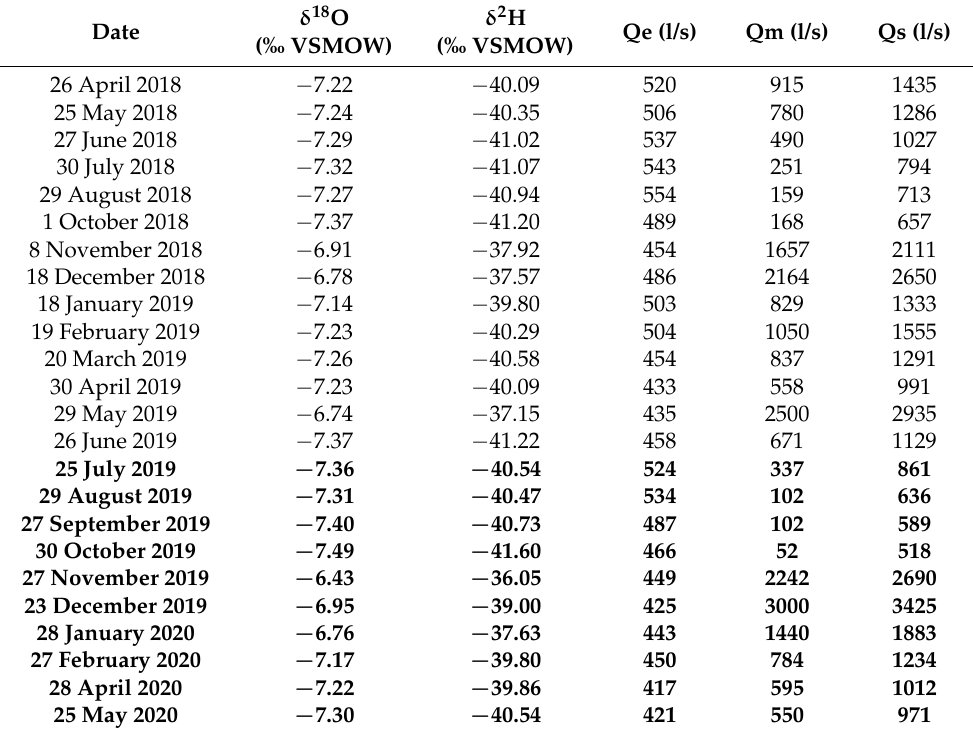
Table 1. Isotope composition of spring water ( δ 18 O, δ 2 H), flow rates exploited by the local water supply (Qe), excess flow rates measured in the river (Qm) and reconstruction of the discharges supplied by Capodacqua di Spigno Spring (Qs), (new data in